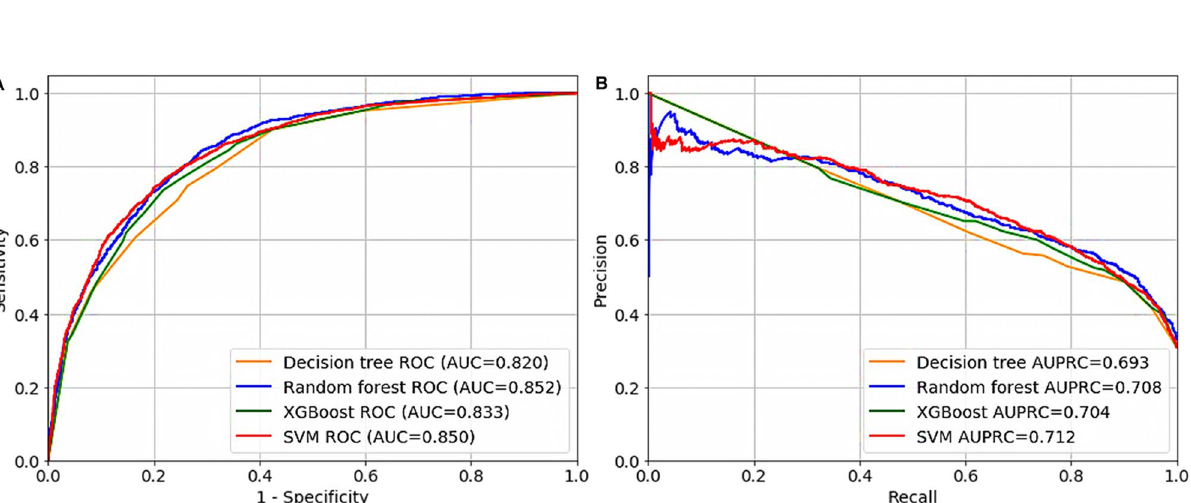
Table 2. Model performance in testing dataset. PPV positive predictive value; CI confidence interval; AUROC area under curve under the receiver operating characteristic curve; AUPRC area under the precision-recall curve; XGBoost extreme gradient boosting; SVM support vector machine.